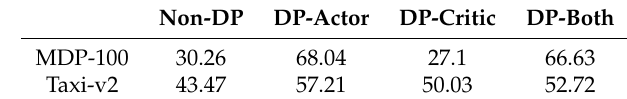
Table 3. Performance Standard Deviation.